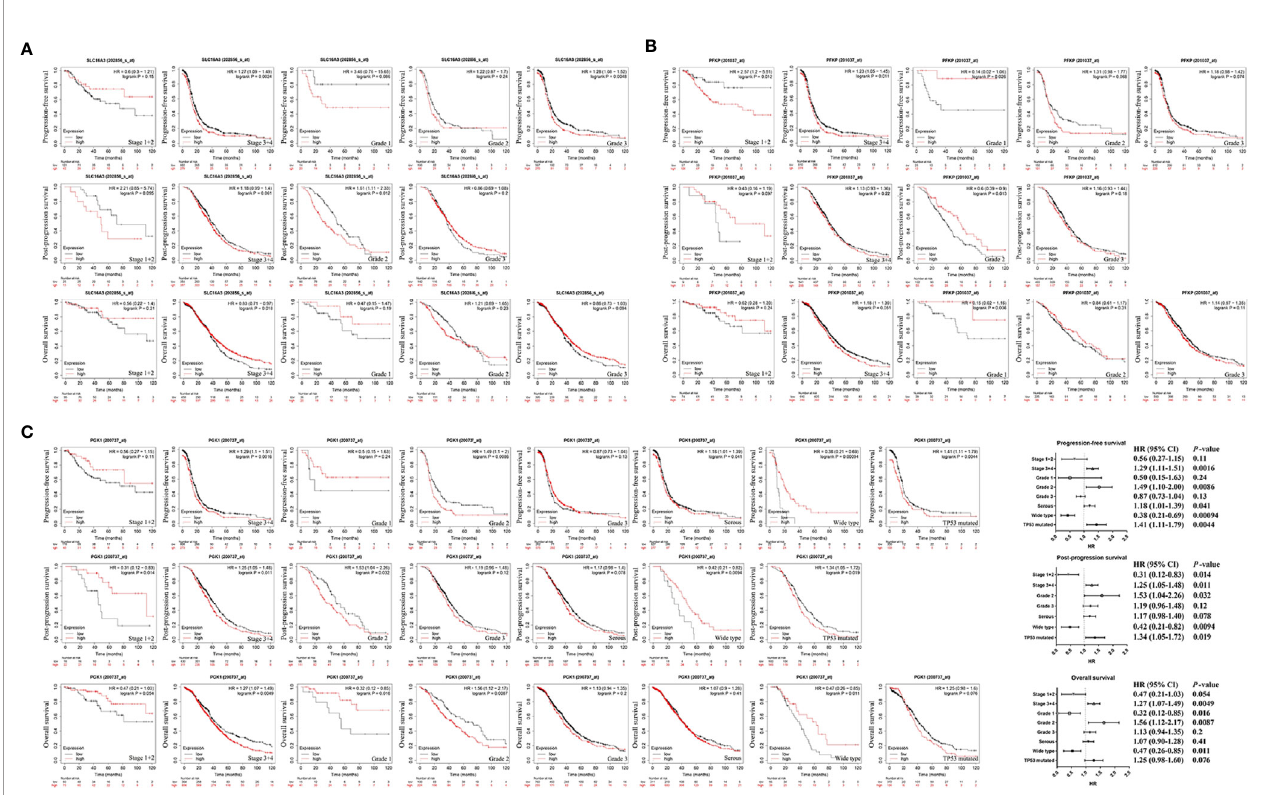
FIGURE 5 | The prognostic value of SLC16A3 , PFKP , and PGK1 in ovarian cancer. (A) The correlation between SLC16A3 expression level and the prognosis of PFS, PPS, and OS in ovarian cancer. (B) The correlation between PFKP expression level and the prognosis of PFS, PPS, and OS in ovarian cancer. (C) The correlation between PGK1 expression level and the prognosis of PFS, PPS, and OS in ovarian